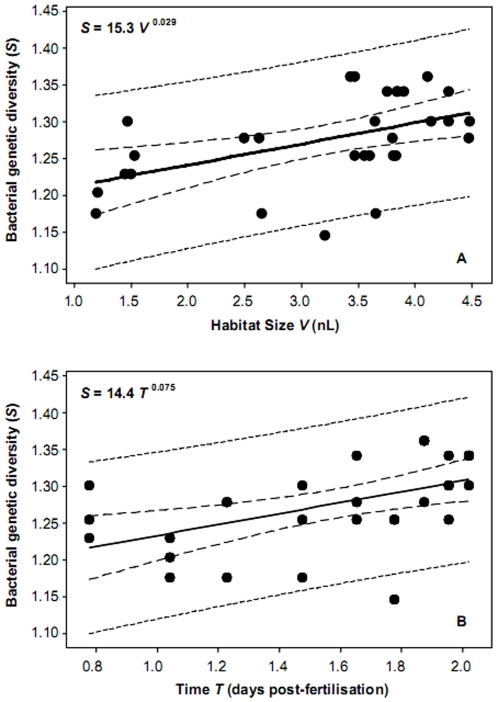
Bacterial richness relationships with (A) habitat size (volume nL) and (B) time (days post-fertilization) plotted on log10 scale axes.Given are the (A) species-volume relationship and (B) species-time relationship power law equations. For (A): r
2 = 0.25, F
1,28 = 9.16, P<0.005; and (B) r
2 = 0.26, F
1,28 = 10.0, P<0.004. Also given are the 95% confidence and prediction intervals (inner and outer dashed lines, respectively).